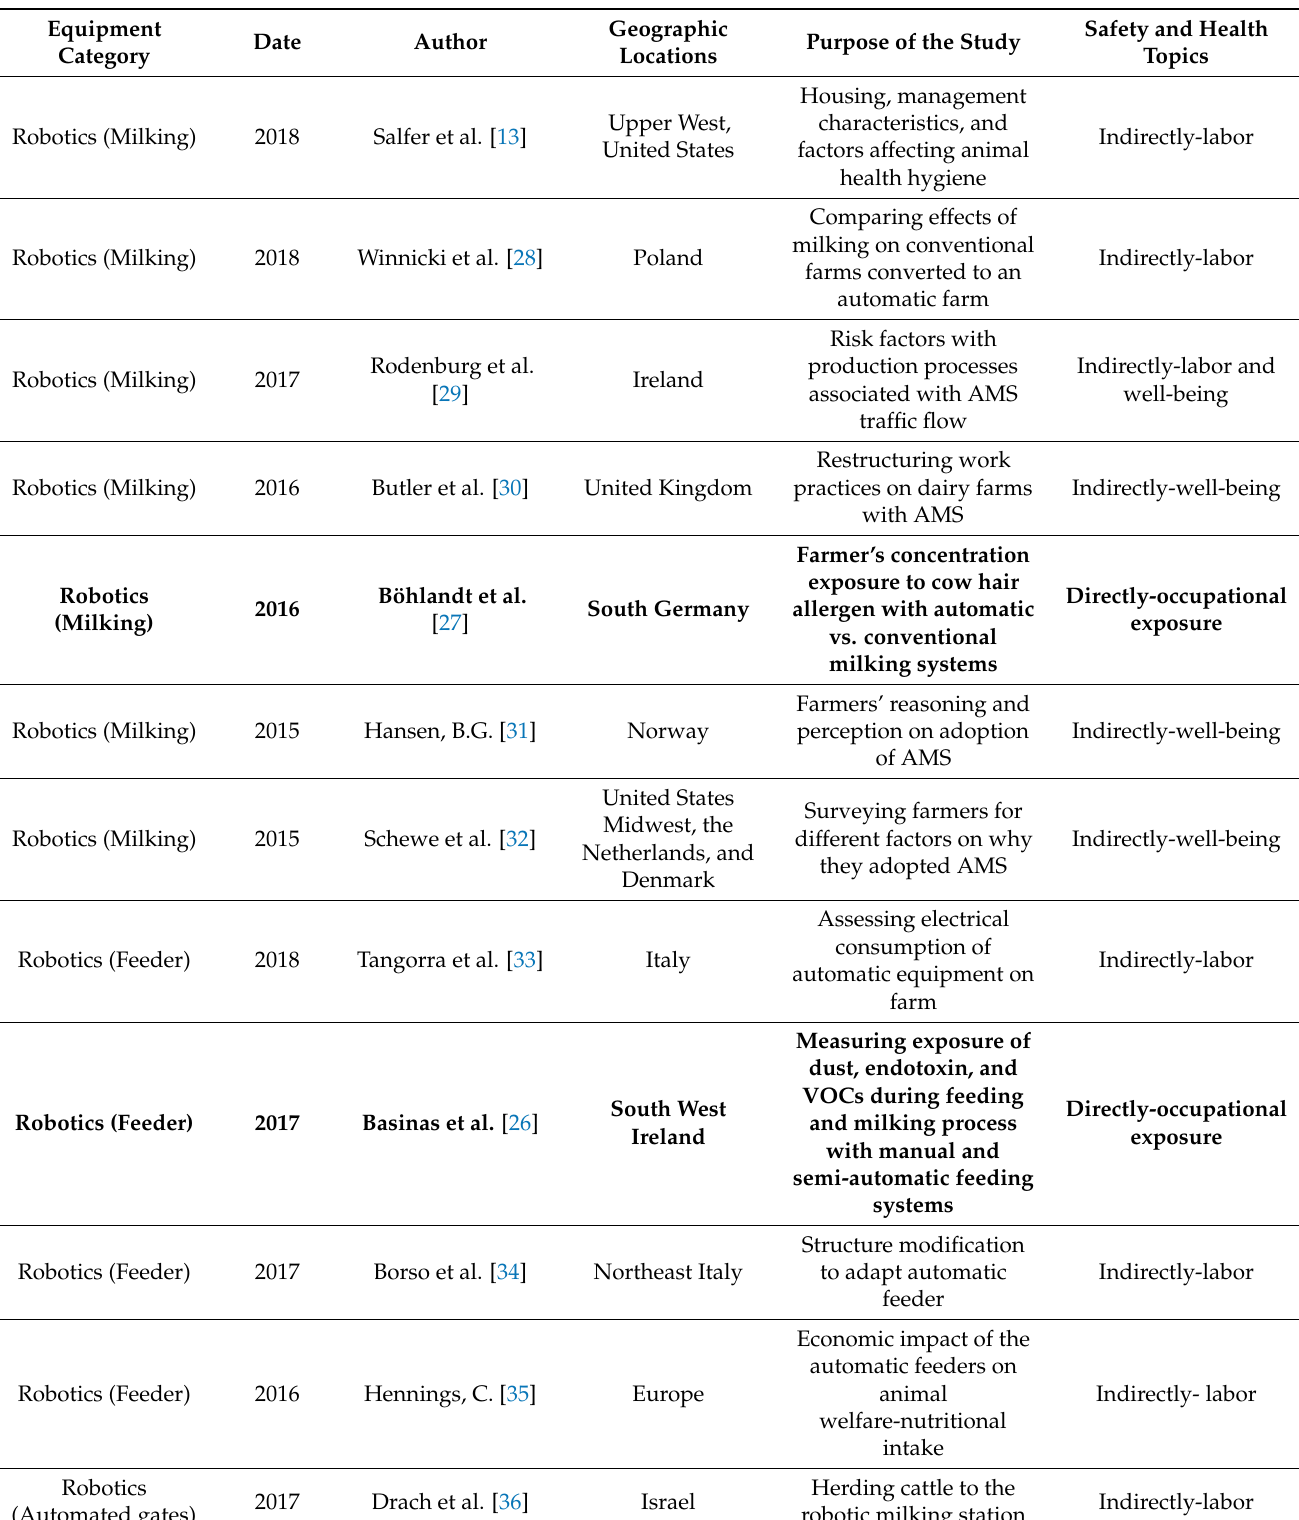
Table 2. Studies that address or discuss the impact of technology on worker safety and